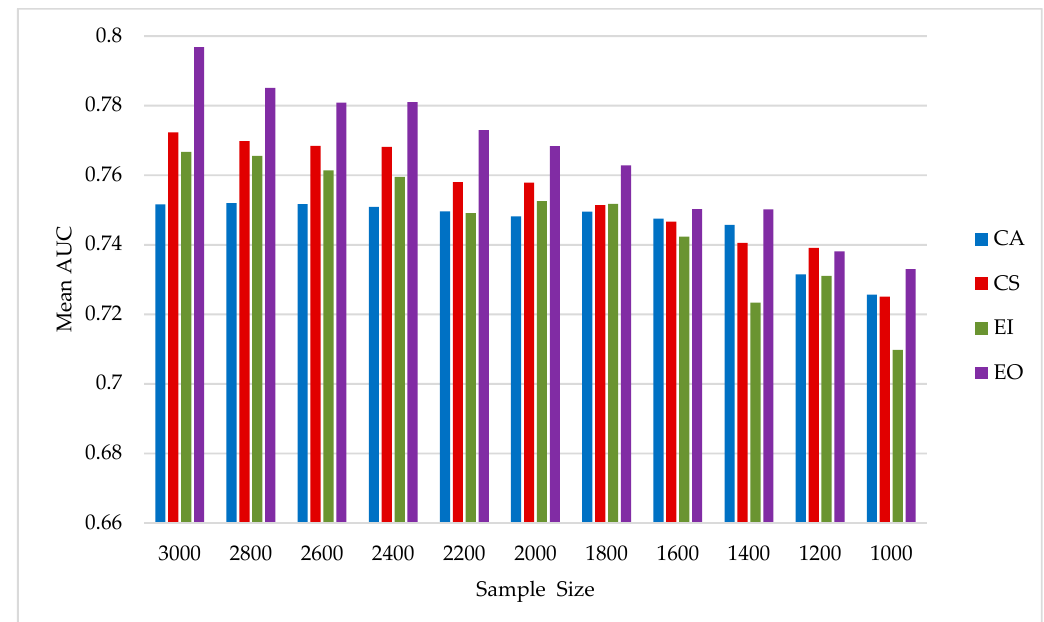
Figure 3. Mean AUC values for different methods with varying sample sizes.